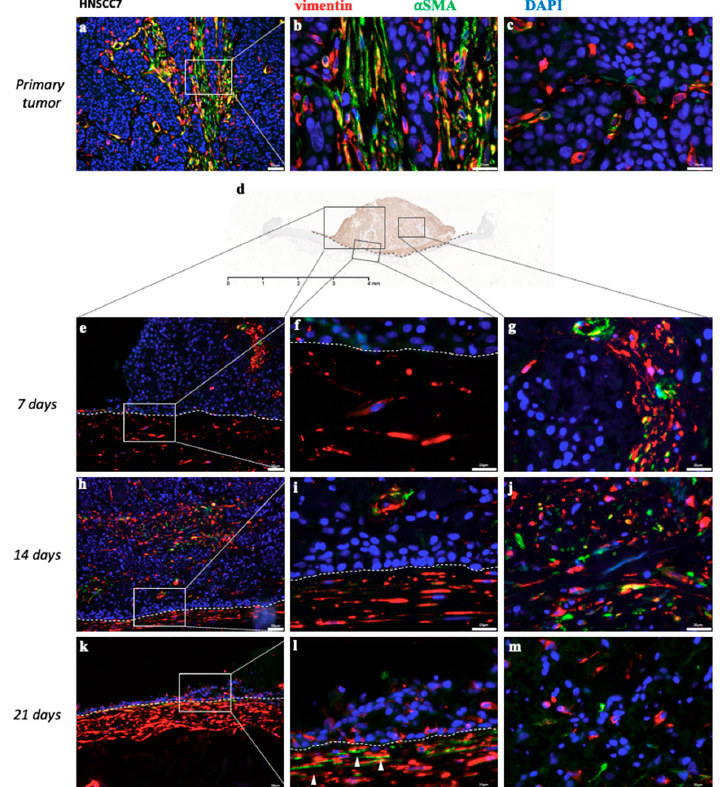
Figure 5. Representative pictures of co ‐ IF staining for vimentin (red), ∝ SMA(green) and DAPI of non ‐ HPV ‐ driven HNSCC7 (invasive type) in 3D ‐ OTC ( e – m ) and primary tumor ( a – c ) as well as an exemplarily overview scan of an IHC staining for PanCK of the according 3D ‐ OTC on day 7 ( d ), that illustrates the localization within the 3D ‐ HNSCC ‐ OTC of the IF images shown below. While ( e , h , k ) show an overview, ( f , i , l ) depict in higher magnification the transition of the tumor, planted on top of the DE, and the DE. The border of both compartments is indicated by dotted lines. ( g , j , m ) show the intratumoral proportion. The primary tumor shows heterogenous ∝ SMA expression in different regions ( b , c ) and ongoing ∝ SMA expression can be detected in intratumoral fibroblasts for up to 21 days in 3D ‐ OTC ( g , j , m ). The fibroblasts within the DE do not express ∝ SMA, but only vimentin on day 7 ( e , f ) and day 14 ( h , i ). On day 21, those fibroblasts in the DE, that are in direct contact to the ITF, start to express ∝ SMA ( l , see white arrowheads). Scale Bar: 4 mm ( d ); 50 μ m ( a , e , h , k ) and 20 μ m ( b , c , f , g , i , j , l , m ). Abbreviations: IHC, immunohistochemistry; IF, immunofluorescence; ∝ SMA, ∝ smooth muscle actin; PanCK; pan ‐ cytokeratin; HPV, human papillomavirus; 3D ‐ OTC, 3D organotypic co ‐ culture; DE, dermal equivalent; HNSCC, head and neck squamous cell carcinoma; ITF, invasive tumor front. 3.1.4. Expression of CD45 as a Pan ‐ Leukocyte Marker in Non ‐ HPV ‐ Driven HNSCC The infiltration of tumor and stroma with immune cells was assessed by CD45 immunohistochemical staining of both non ‐ HPV ‐ driven ( n = 7) and HPV ‐ driven ( n = 6) (see Section 3.2.4) HNSCC. We aimed to determine whether infiltration levels were stable during cultivation and consistent in primary tumor and 3D ‐ OTCs. Expression levels were divided into negative (0), low (1), moderate (2) and high (3) expression (Figure 6A). Primaries of non ‐ HPV ‐ driven HNSCC showed low immune cell proportions, that remained stable during culture in 3D ‐ OTC (see Figure 6B,D).